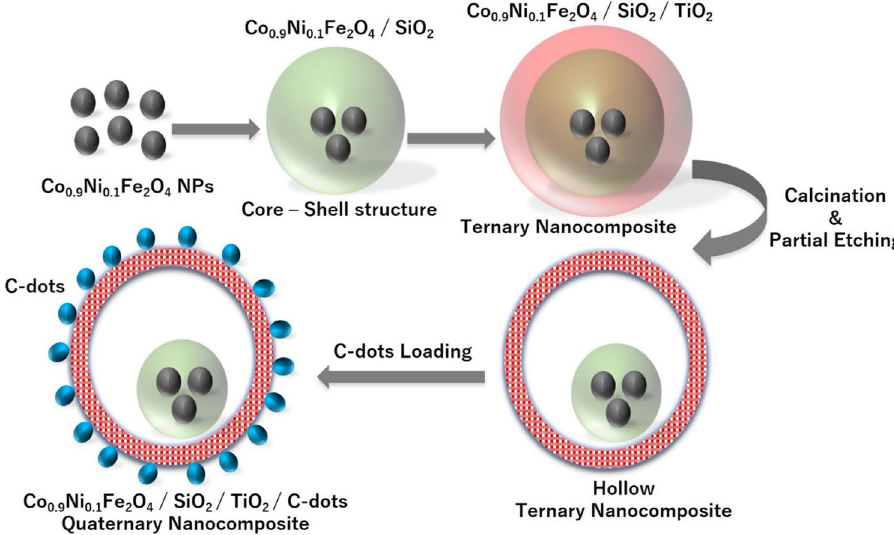
Figure 1. Schematic representation of the mechanism of Co x Ni 1−x Fe 2 O 4 ; x = 0.9/SiO 2 /TiO 2 /C-dots nanocomposite